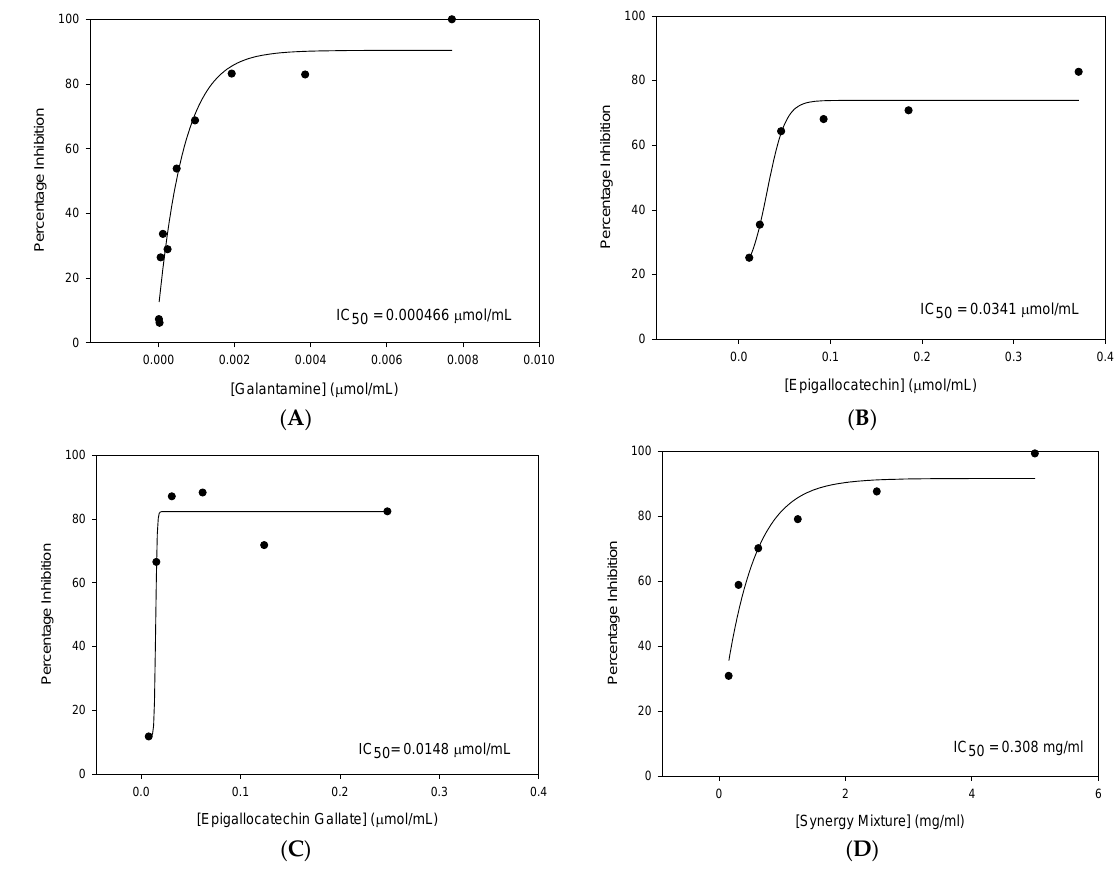
Figure 1. IC 50 plots of AChE inhibition: concentration against percentage inhibition for each of the active compounds tested. ( A ) galantamine, ( B ) epigallocatechin, ( C ) epigallocatechin-3-gallate and ( D ) synergy